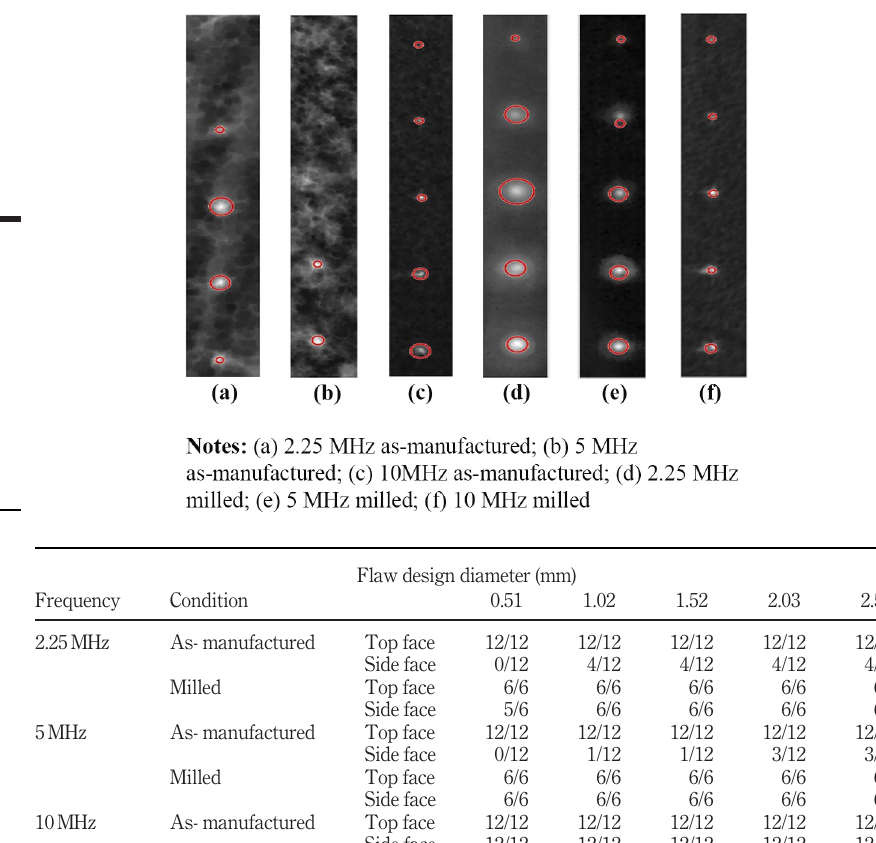
Table V. Number of designed defects